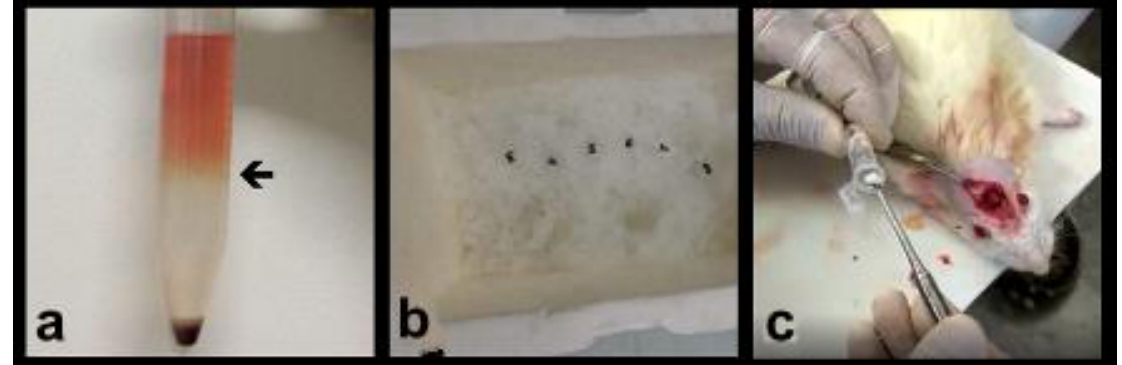
Figure 1. ( a ) Obtaining the BMMF: polypropylene tube after separation by density gradient: plasma platelets, mononuclear cells (arrow), Ficoll-Histopaque, granulocyte–erythrocyte. ( b ) The 1 mL Ependorf tubes were prepared with 1 × 10 6 cells diluted in 300 μL of ice-cold PBS, pH 7.2. ( c ) The final suspension of the BMMF was added to the synthetic hydroxypatite and the xenograft, 0.10 g in 300 μL of FMMO in the concentration of 1 × 10 6 cells.